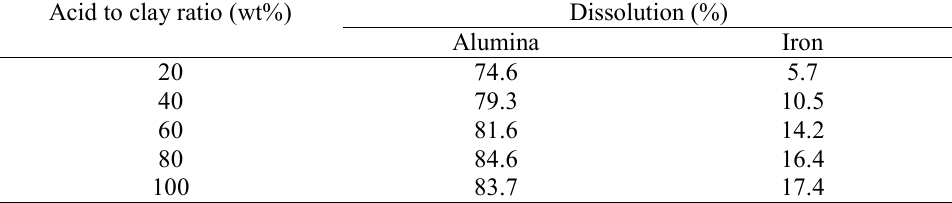
Table 5. Effect of acid to clay ratio on the dissolution of alumina and iron at different acid to clay ratios, with calcination at 750 o C for 30 min and leaching with 3M sulfuric acid at 80 o C for 120 min.